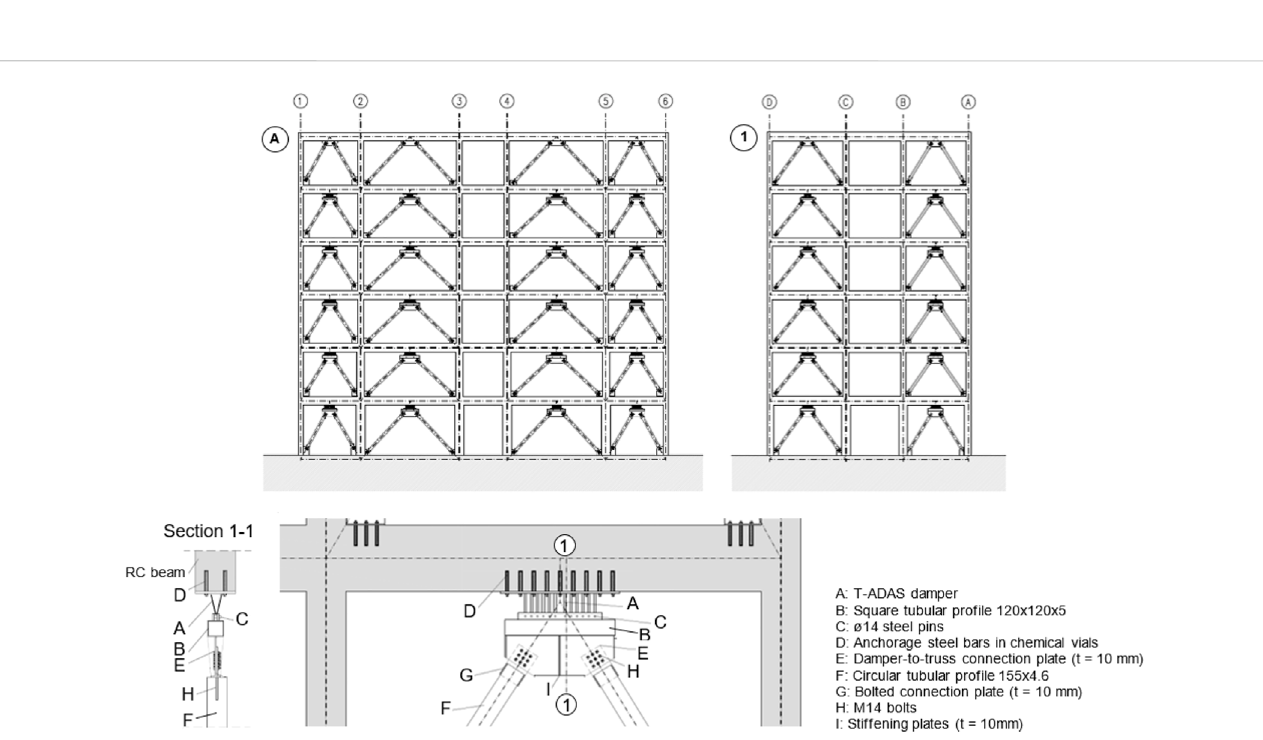
FIGURE 8 Front views of the retro fi tted structure along A and 1 horizontal fi xed lines, and installation details of the dissipative bracing system in a span of the frame structure.